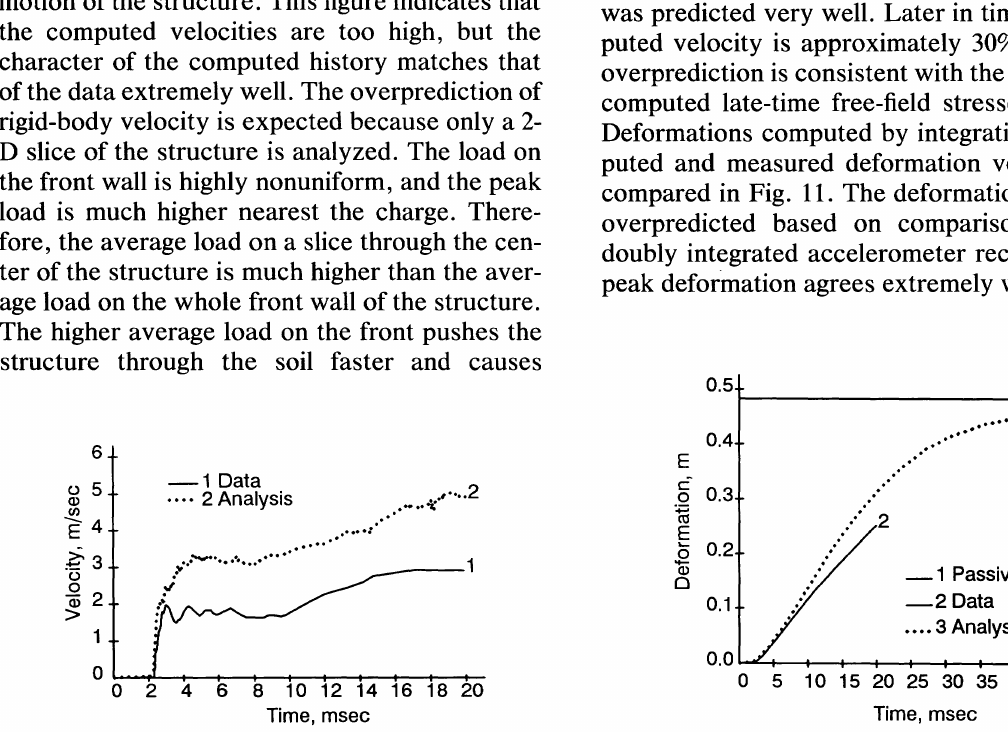
FIGURE 8 Free-field velocities.